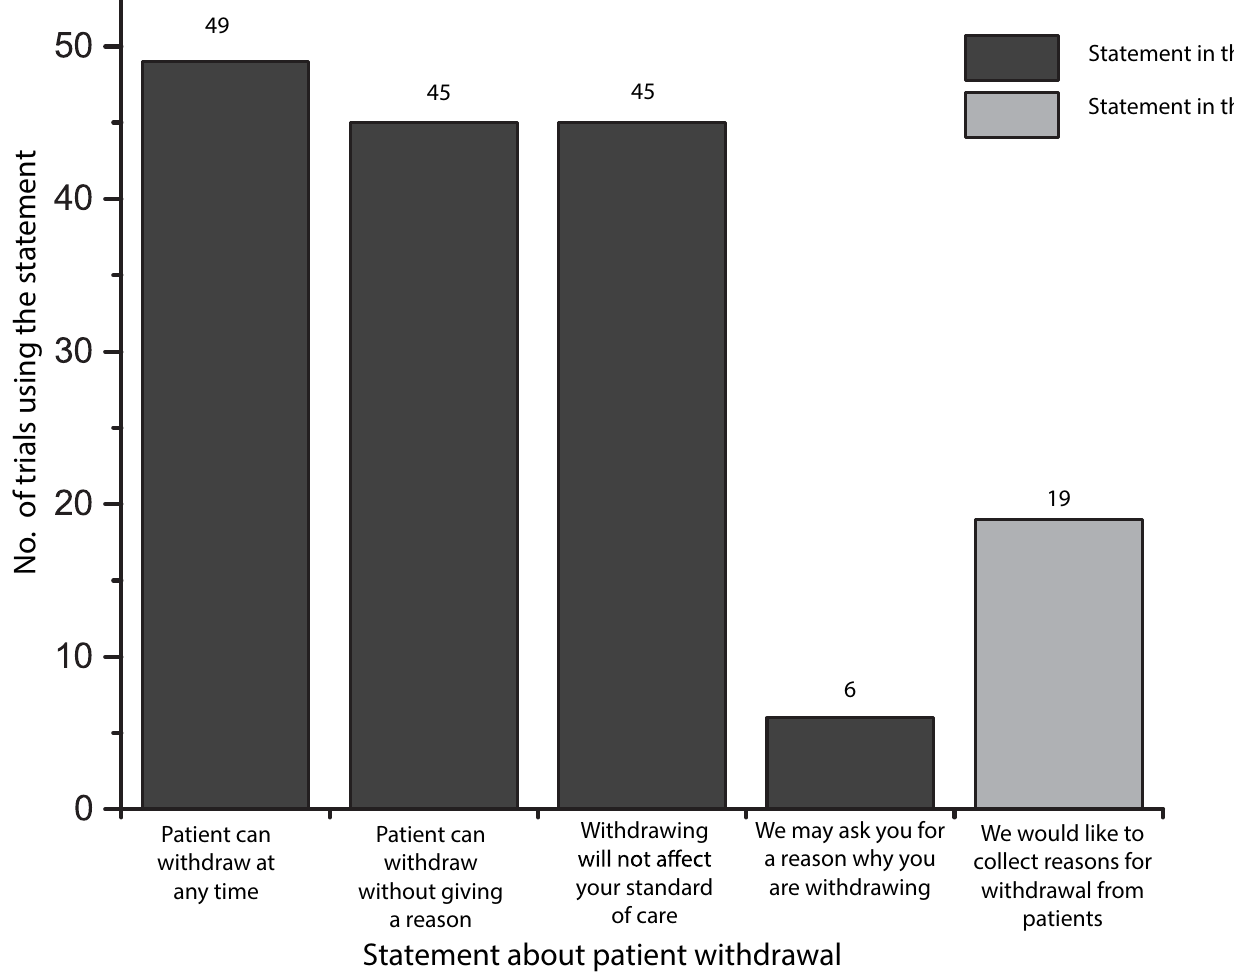
Fig 3. Frequency of communication about patient withdrawal within PIL and protocols (n =